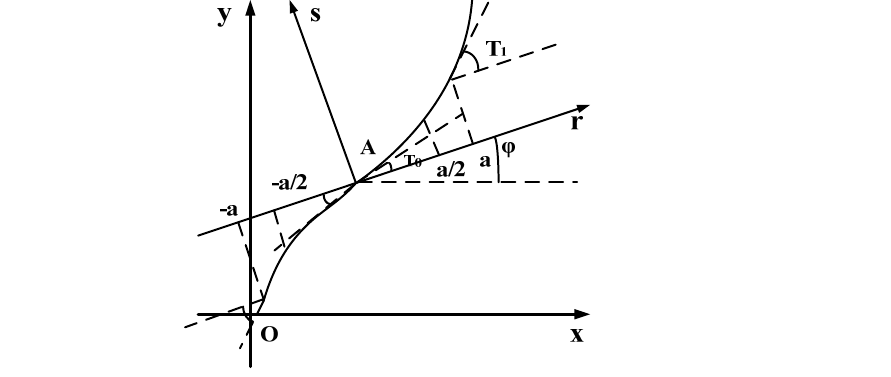
Figure 4. Fiber curve placement reference path planning.